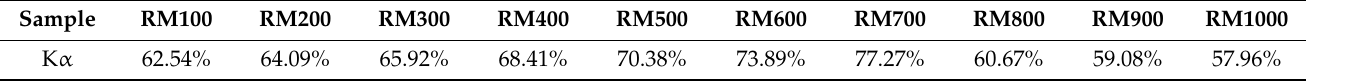
Figure 2. The compressive strength of samples at different temperatures. Table 2. The pozzolanic activity index of calcined RM at different